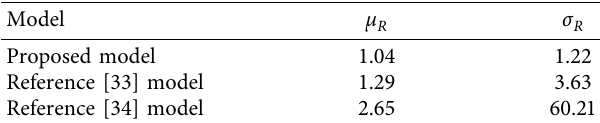
Table 4: Comparison of the precision of models.